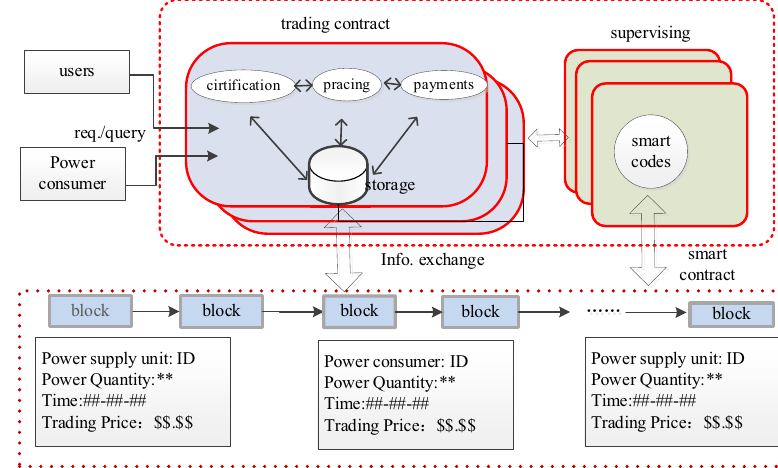
Fig. 2. Procedure of blockchain-based power trading